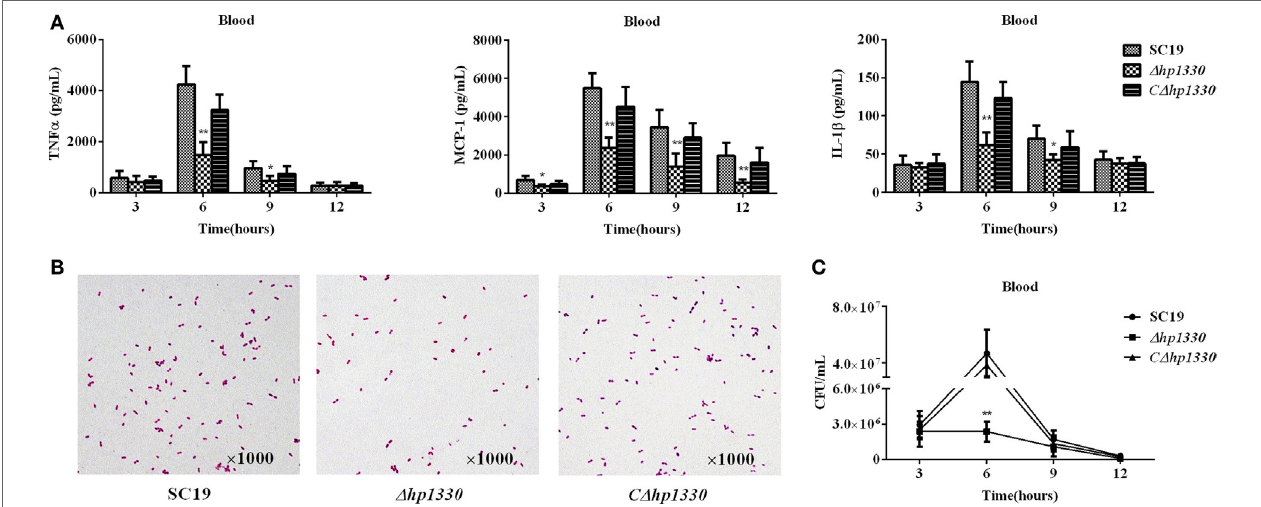
FigUre 7 | Cytokine concentrations and bacterial loads in blood. Female C57BL/6 mice were challenged with 2 × 10 8 colony-forming units of the SC19, Δ hp1330 , or C Δ hp1330 strain cultured on tryptic soy agar. After infection for 3, 6, 9, or 12 h, an equal number of mice in each group were sacrificed to collect blood. (a) The blood cytokine concentrations were determined by enzyme-linked immunosorbent assay. (b) The morphologies of the SC19, Δ hp1330 , and C Δ hp1330 strains from blood were observed under a light microscope by Gram staining ( × 1,000). (c) Bacteria loads in the blood were examined by determining colony-forming unit counts. The results shown are representative of three independent experiments. * P < 0.05, ** P < 0.01.